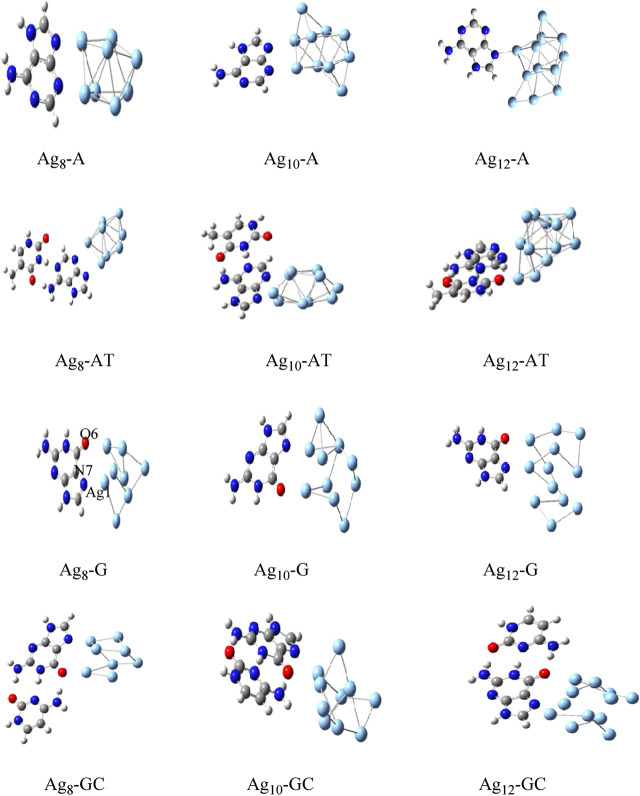
Optimized structures of Agn-A,T/WC complexes for n = 8, 10 and 12 by DFT method (Srivastava, 2018a).